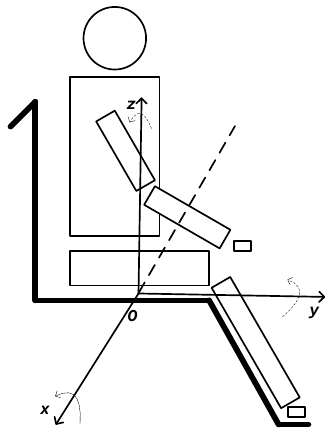
Figure 1. Body posture analyze model of sitting behavior.